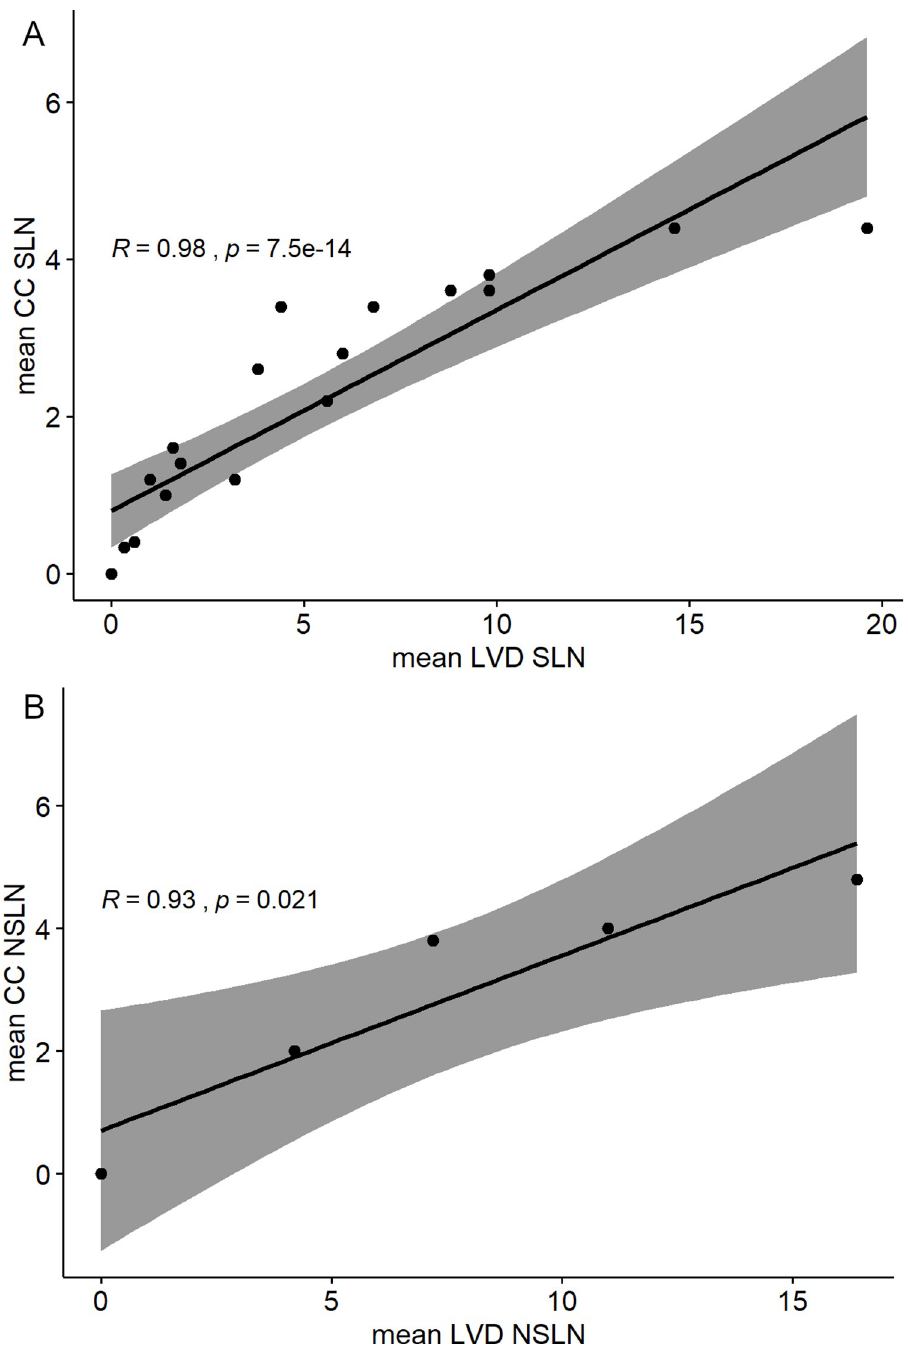
Fig 2. Correlation of both morphometric quantification methods, lymphatic vessel density and Chalkley count. Mean values of lymphatic vessel density (LVD) and Chalkley Count (CC) of all cases analyzed are graphically illustrated and correlated using Spearman‘s or Pearson’s correlation coefficient, displaying equivalence of both quantification methods.